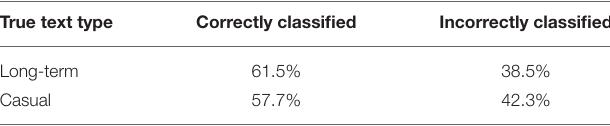
TABLE 4 | Percentages of correctly and incorrectly classified texts based on the distinctive content-specific features.